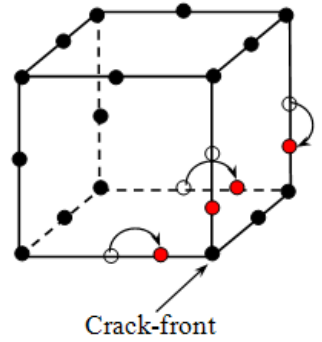
Figure 2: A typical Finite element used at